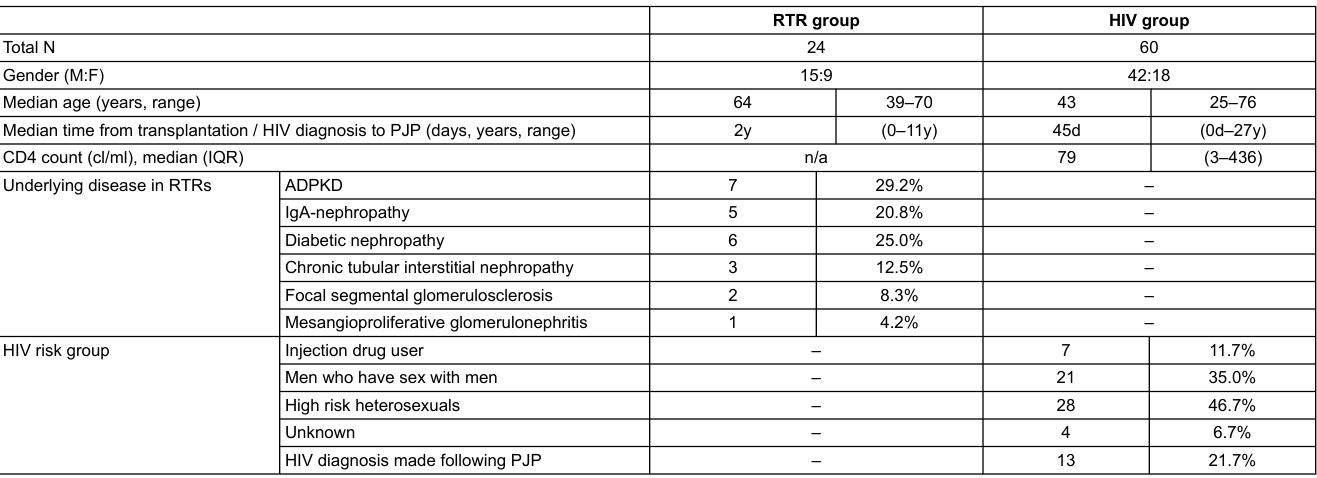
Table 1: Demographic